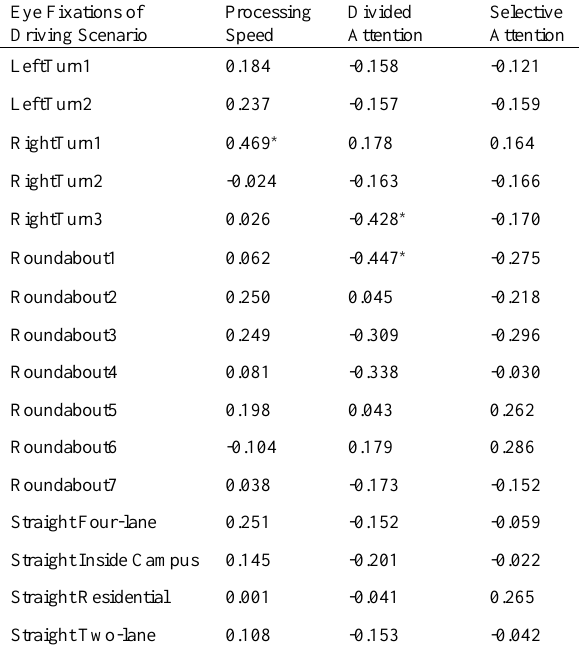
Correlation coefficients between visual capacity and fixation fre- quency and manoeuvre time at different driving scenarios (*p<.05; **p<.01,